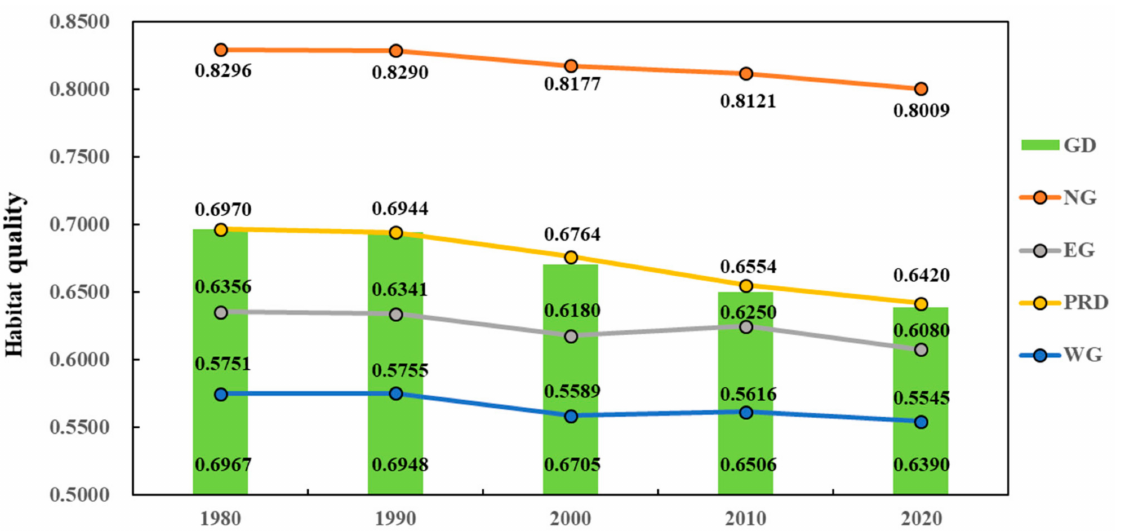
Figure 5. Annual average habitat quality of Guangdong and its sub-regions from 1980 to 2020. (Note: GD refers to Guangdong; NG refers to northern Guangdong; EG refers to eastern Guangdong; PRD refers to Pearl River Delta; WG refers to western Guangdong